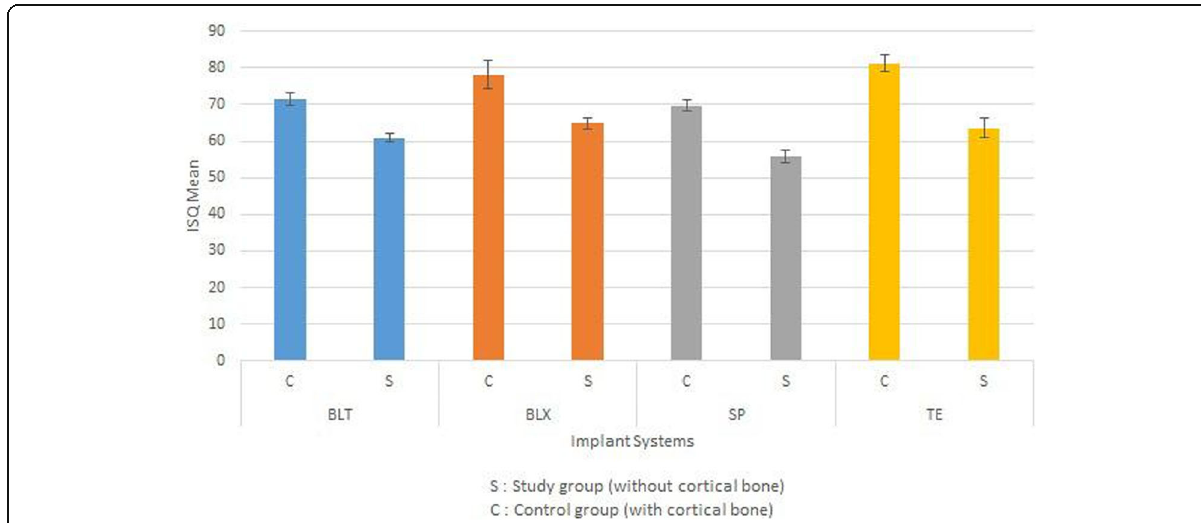
Fig. 5 The decrease in percentage was lowest in the BLX group, followed by BLT. The difference was significant compared to the loss of mechanical anchorage obtained in the TE group (p 0.033 and p 0.008, respectively)